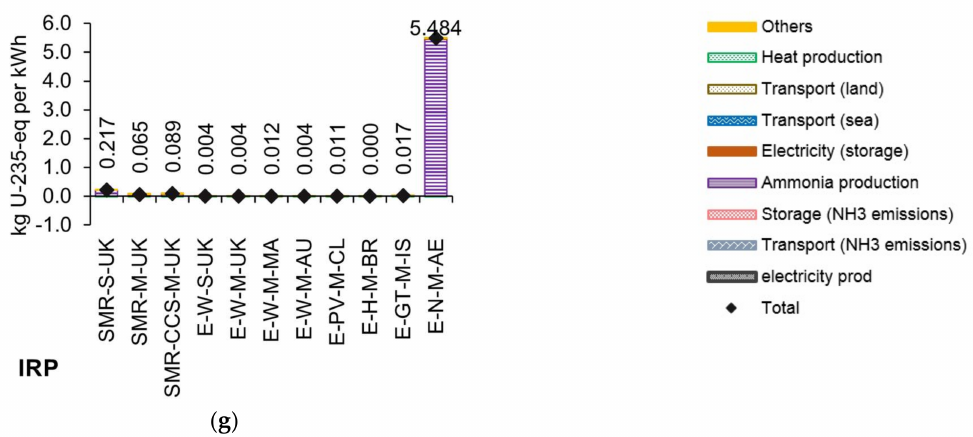
Figure 6. Impact category indicator results with contribution analysis of ammonia-based electricity in co-generation cycle, FU: 1 kWh of electricity at the plant. ( a ) global warming potential (GWP100), ( b ) fossil depletion potential (FDP), ( c ) freshwater eutrophication potential (FEP), ( d ) ozone depletion potential (ODP), ( e ) photochemical oxidation formation potential (POFP), ( f ) terrestrial acidification potential TAP100, ( g ) ionizing radiation potential (IRP). SMR: steam methane reforming, E: electrolysis, CCS: carbon capture and storage, S: small-scale 20,000 ton per annum ammonia plant, M: mid-scale 100,000 ton per annum ammonia plant, PV: photovoltaic, W: wind, H: hydro, GT: geothermal, N: nuclear, UK: